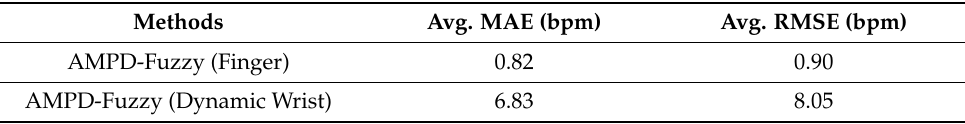
Table 6. The tracking errors of